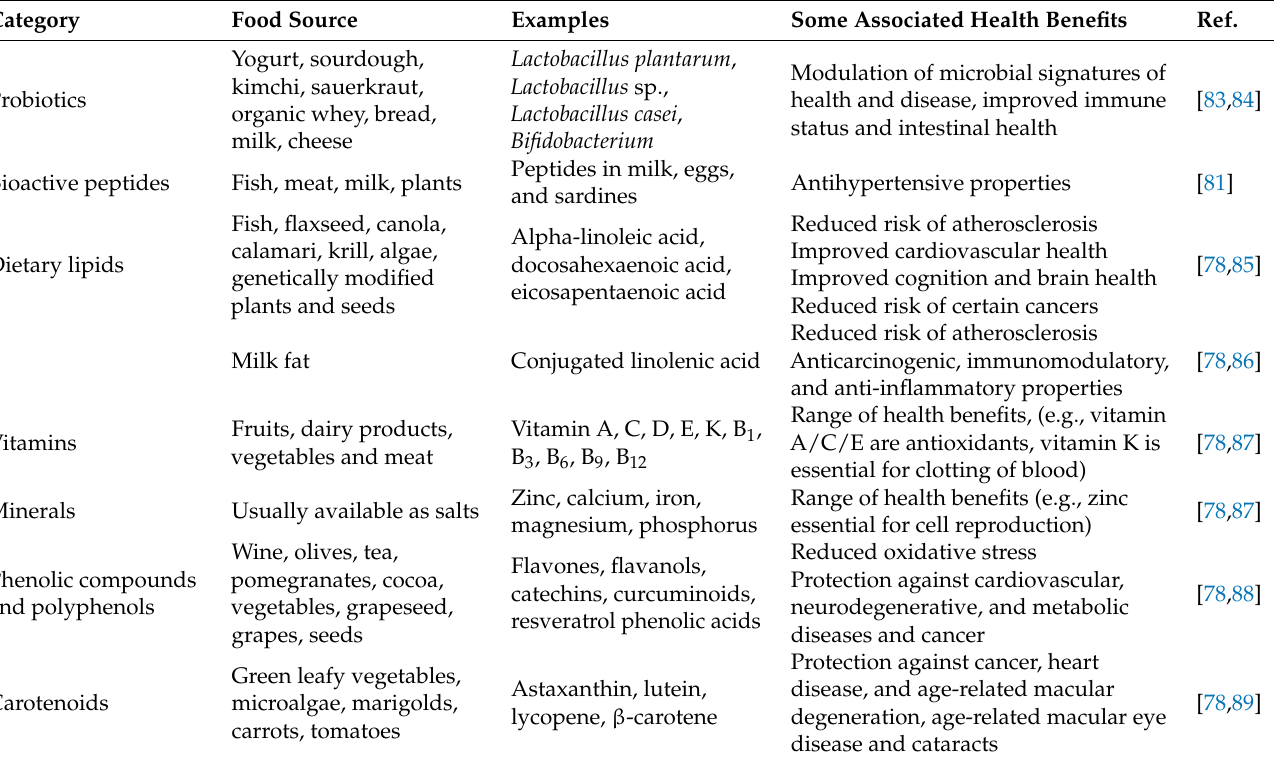
Table 3. Selected nutraceuticals of interest to the food industry, and their associated health